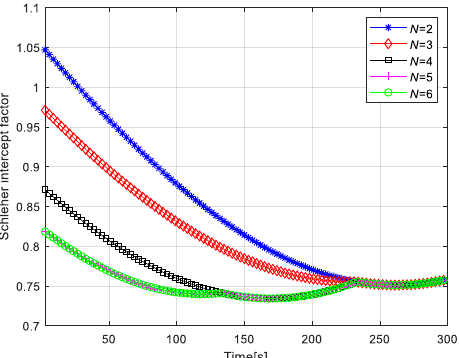
Figure 12. Total Schleher intercept factor.